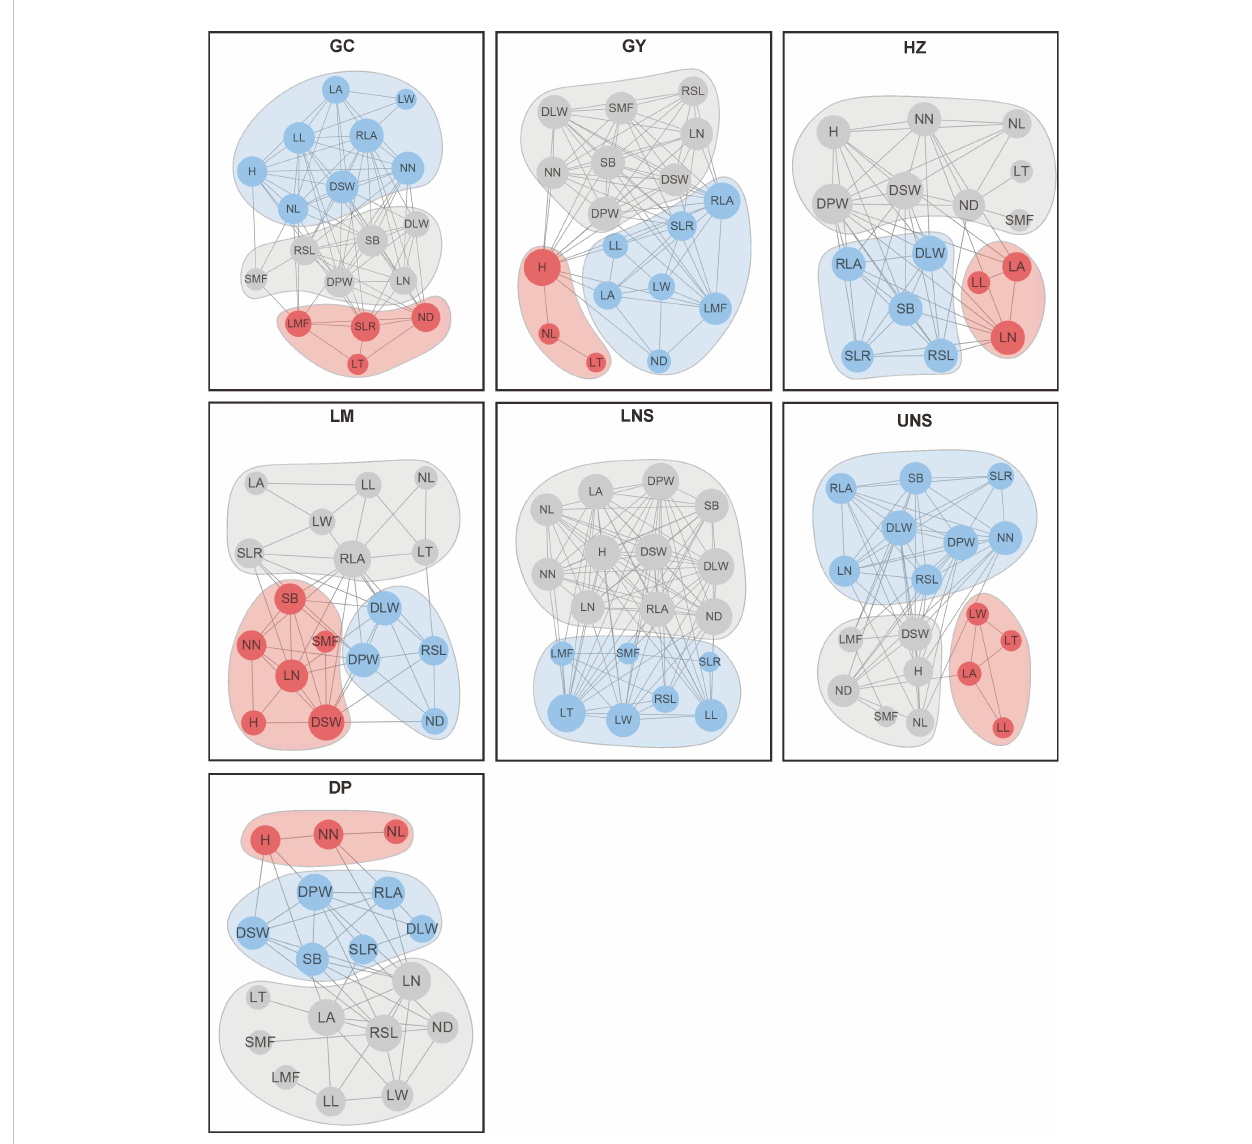
FIGURE 6 Plant trait network of submerged macrophytes in impounded lakes and Grand Canal. H, Plant height; SB, Stem branch; NN, Internodes number; NL, Internode length; ND, Internode diameter; RSL, Relative stem length; LN, Leaf number; LT, Leaf thickness; LL, Leaf length; LW, Leaf width; LA, Leaf area; RLA, Relative leaf area; DPW, Dry plant weight; DSW, Dry stem weight; DLW, Dry leaf weight; SLR, Ratio of stem weight to leaf weight; SMF, Stem dry mass fraction; LMF, Leaf dry mass